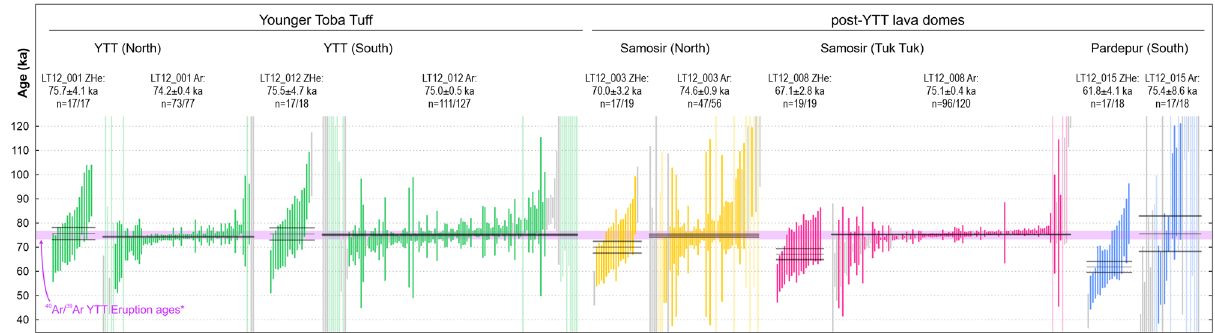
Fig. 2 Summary of ZHe and Ar geochronological data for YTT and post-YTT lava domes. Rank order plots of single-crystal ZHe data recalculated from Mucek et al. 25 and single-crystal Ar data produced by incremental heating or total fusion from this study, colour-coded according to the Fig. 1. Coloured vertical bars correspond to 2 sigma uncertainties for individual analyses; grey analyses are not included in the weighted mean/plateau age calculation for the reasons given in Supplementary Data 2 and 3; translucent analyses are out of scale (full data are listed and shown in Supplementary Data 2). The thin grey horizontal lines through each population represent the weighted mean (for ZHe data) or plateau age (for Ar data), the outer thick grey horizontal lines mark the corresponding 2 sigma uncertainty. Labels: sample code, type of analysis (ZHe or Ar), age and 2 sigma uncertainty in ka, number of analyses — considered for age calculation and total, respectively. Purple rectangle across the length of the fi gure represents the currently accepted YTT eruption ages based on sanidine Ar data of Mark et al. 20 and Storey et al. 19 . Note that (i) the weighted mean ZHe ages and Ar plateau ages for YTT samples overlap within uncertainty with the accepted YTT eruption age, which proves the accuracy of the techniques used. (ii) The weighted mean ZHe ages (interpreted to represent the time of eruption) for all post-YTT domes are younger (outside the uncertainties) than the corresponding Ar ages as well as the accepted YTT eruption age. This suggests that the post-YTT domes erupted signi fi cantly later than the closure of the Ar system and after the YTT